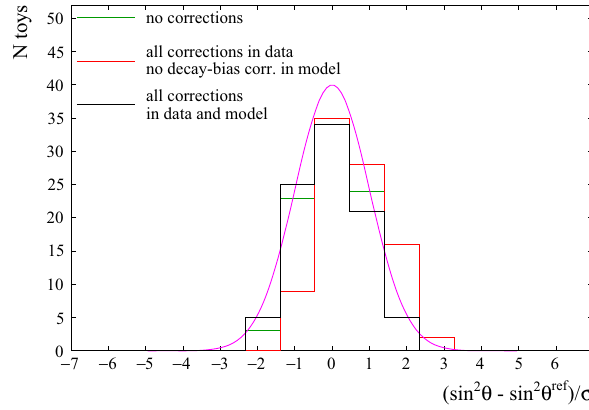
Fig. 9 The pull distributions for 90 toy measurements of (left) m W + bias corrections are not included in the the templates (red); (3) the pseu- domass and decay-asymmetry corrections are applied to both toy data and (right) sin 2 θ eff . Three different scenarios are represented: (1) the lept and templates (black). Note that, in the case of m W , the three distribu- pseudomass and decay-asymmetry bias corrections are not included in the toy data and template events (green); (2) the pseudomass correc- tions overlap. The expected statistical behaviour, represented by a unit tions are applied to toy data and templates, but the decay-asymmetry Gaussian, is drawn in magenta